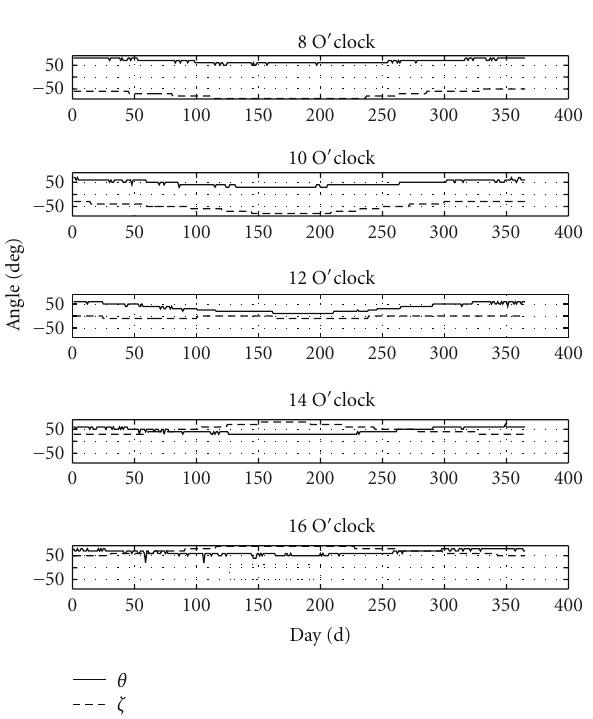
Figure 8: Optimal azimuth ζ (dashed lines) and inclination θ (solid lines) angles are plotted for di ff erent times in the day over all the year.